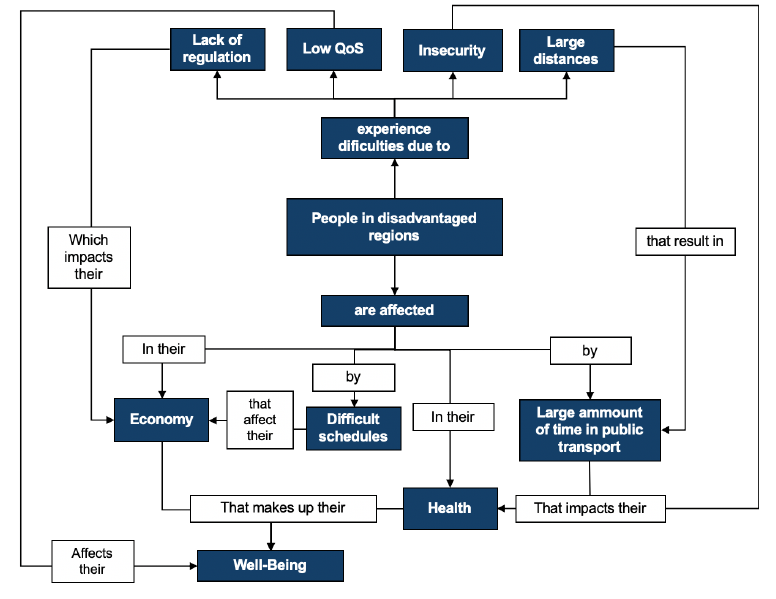
Figure 1. Conceptual model showing the emergent topics from the